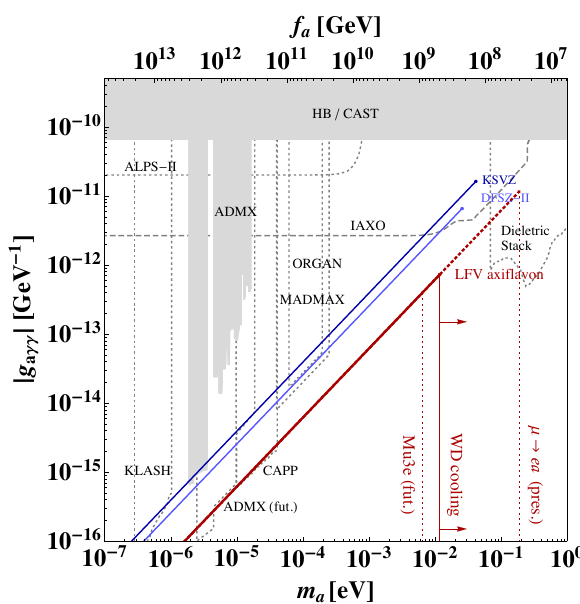
Figure 11 . Present bounds and projected sensitivity for the LFV axiflavon model illustrated in section 7.2, with the LFV couplings given in eq. (7.30). The red bold solid line shows the predicted coupling to photons (as defined in eq. (7.16)) of the LFV axiflavon model. The solid red vertical line shows the upper bound on the axion mass from star cooling while the dotted red vertical lines the present bound and future sensitivity from LFV axion searches. The grey shaded and grey dotted regions, and the blue and dark blue lines are the same as in figure